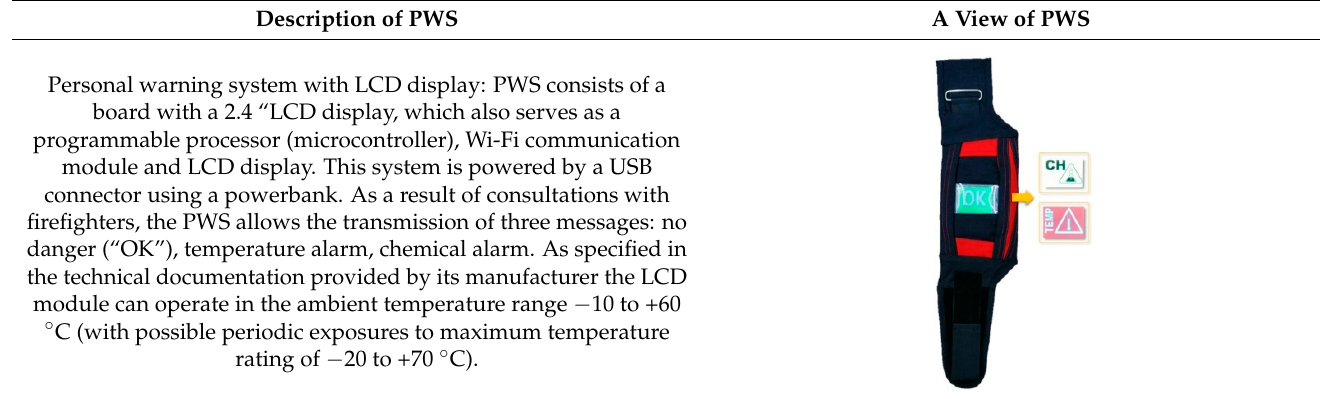
Table 1. Personal warning systems (PWSs).